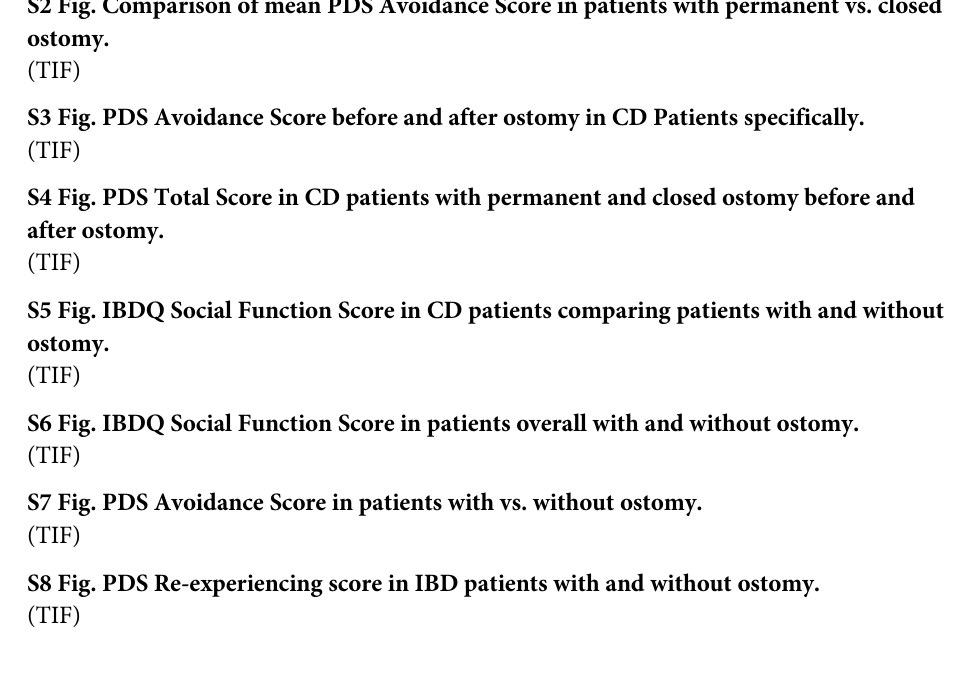
S1 Fig. Antibiotics used in UC patients before and after ostomy according to stoma type. S2 Fig. Comparison of mean PDS Avoidance Score in patients with permanent vs. closed ostomy. S3 Fig. PDS Avoidance Score before and after ostomy in CD Patients specifically. S4 Fig. PDS Total Score in CD patients with permanent and closed ostomy before and after ostomy. S5 Fig. IBDQ Social Function Score in CD patients comparing patients with and without ostomy. S6 Fig. IBDQ Social Function Score in patients overall with and without ostomy. S7 Fig. PDS Avoidance Score in patients with vs. without ostomy. S8 Fig. PDS Re-experiencing score in IBD patients with and without